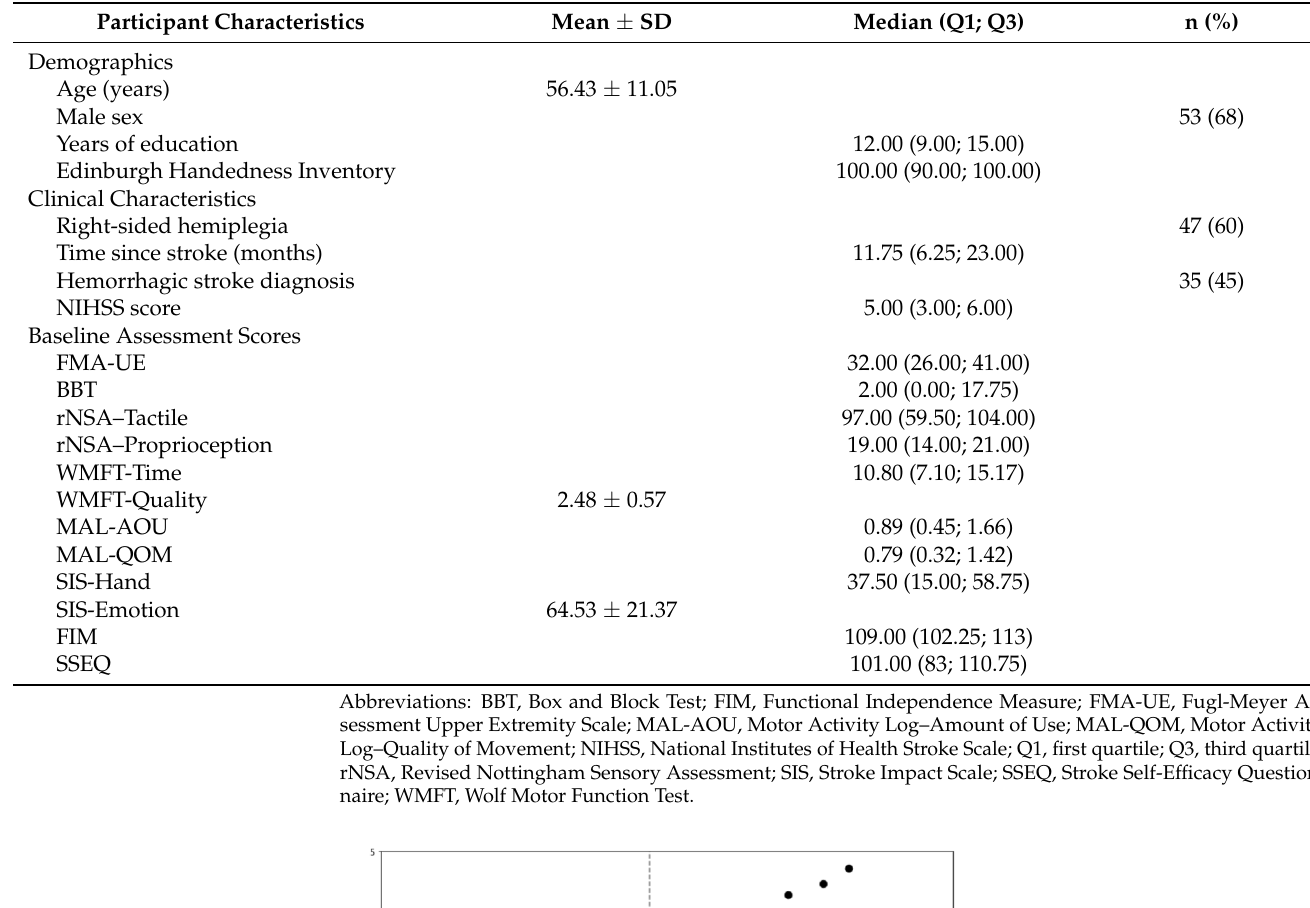
Table 1. Participant demographics and preintervention assessment scores.